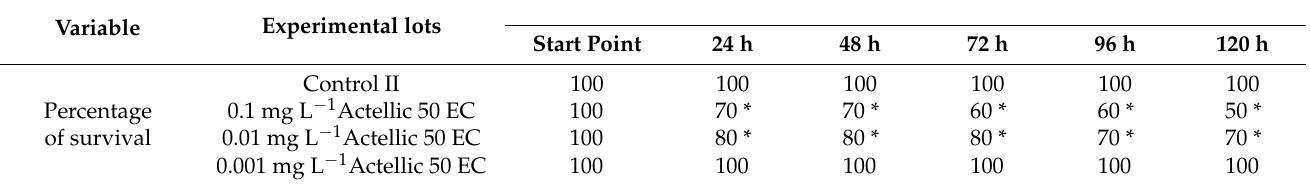
Table 9. The percentage of survival on Pelophylax ridibundus tadpoles intoxicated with Actellic 50 EC